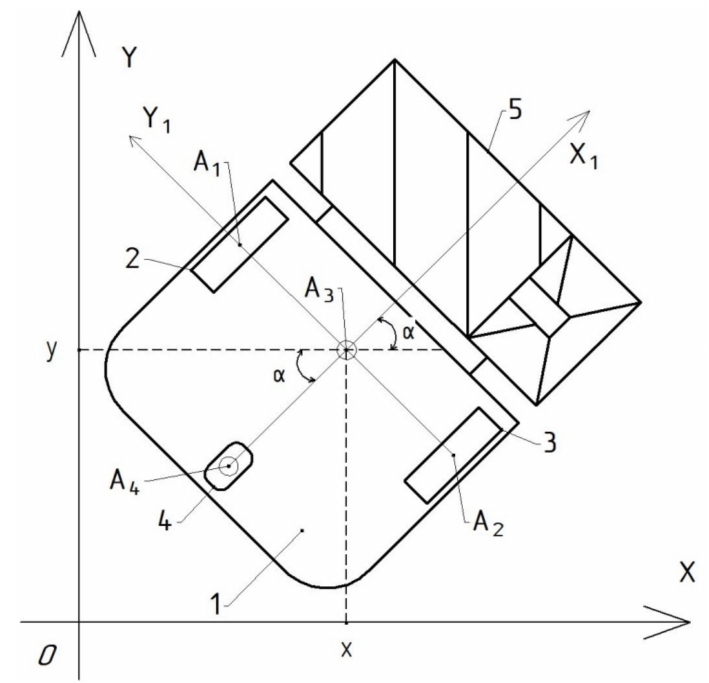
Figure 4. Design scheme describing the robot motion kinematics. 1, mobile platform; 2, drive wheel; 3, drive wheel; 4, support wheels; 5, pushing auger. A 1 —the fulcrum of the left driving wheel, A 2 —the fulcrum of the right driving wheel, A 3 —the center of mass of the robot, A 4 —the point of support of the driven